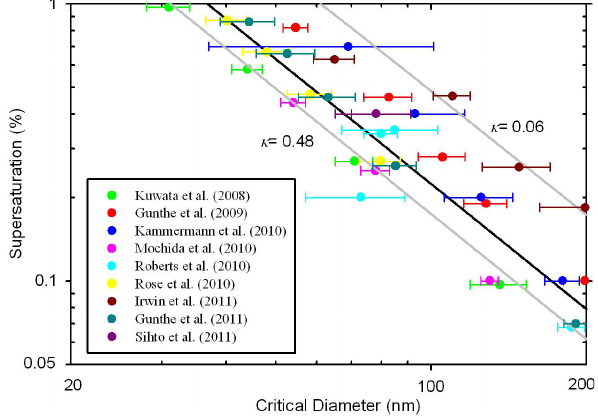
Fig. 1. The relationship between the particle dry size and the critical supersaturation. The calculations were done for the temperature of 298.15 K and under assumption that the droplet surface tension is that of water, i.e. 0.072Nm − 1 . The scale of the y-axis corresponds to maximum supersaturations reported for various cloud types in Table 17.3 of Seinfeld and Pandis (2006). The calculations are done for κ values of 0.27 (black line) and for 0.48 and 0.06 (grey lines) which correspond to the simulated global mean of κ = 0 . 27 ± 0 . 21 (Pringle et al., 2010). Also, results from several field studies are displayed in symbols (see legend). The horizontal bars indicate re- ported standard deviations. For the study of Irwin et al. (2011), the results from terrestrial periods are presented (see Table 1 of the pub- lication). Also, Irwin et al. (2011) reported standard deviations for the critical supersaturations, and these were converted to the corre- sponding critical diameters using Eq.